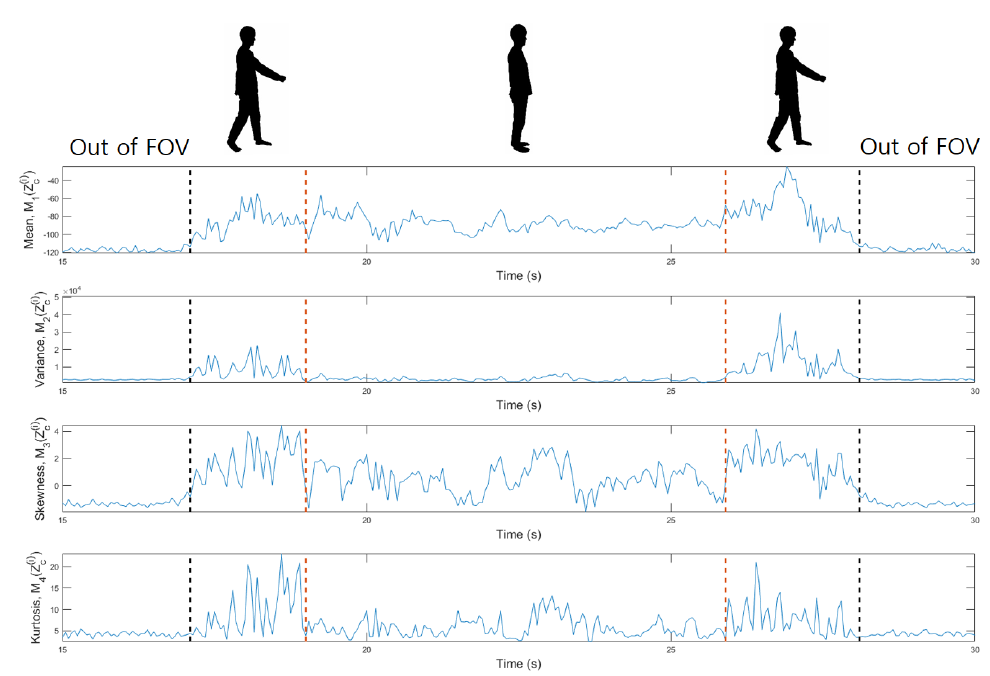
Figure 9. Changes in the values of four probabilistic moments according to the change of motion. Of the four moments, we confirmed that the 2nd order moment (i.e., variance) has the most pronounced change in its value depending on the motion. Thus, to find the boundary time between two motions, we applied the change point detection (CPD) algorithm [30] (cid:17) (cid:16) ( i ) Z to M 2 . The CPD is a method of finding the point at which the characteristic of the c distribution changes in time series data, and can be applied directly to the four moment values we calculated. Figure 10a shows the result of applying the CPD algorithm to the (cid:16) (cid:17) ( i ) Z values of M 2 in Figure 9. As shown in the figure, the CPD algorithm accurately finds c the moments when the motion changes and the absolute time estimation error was 62.5 ms